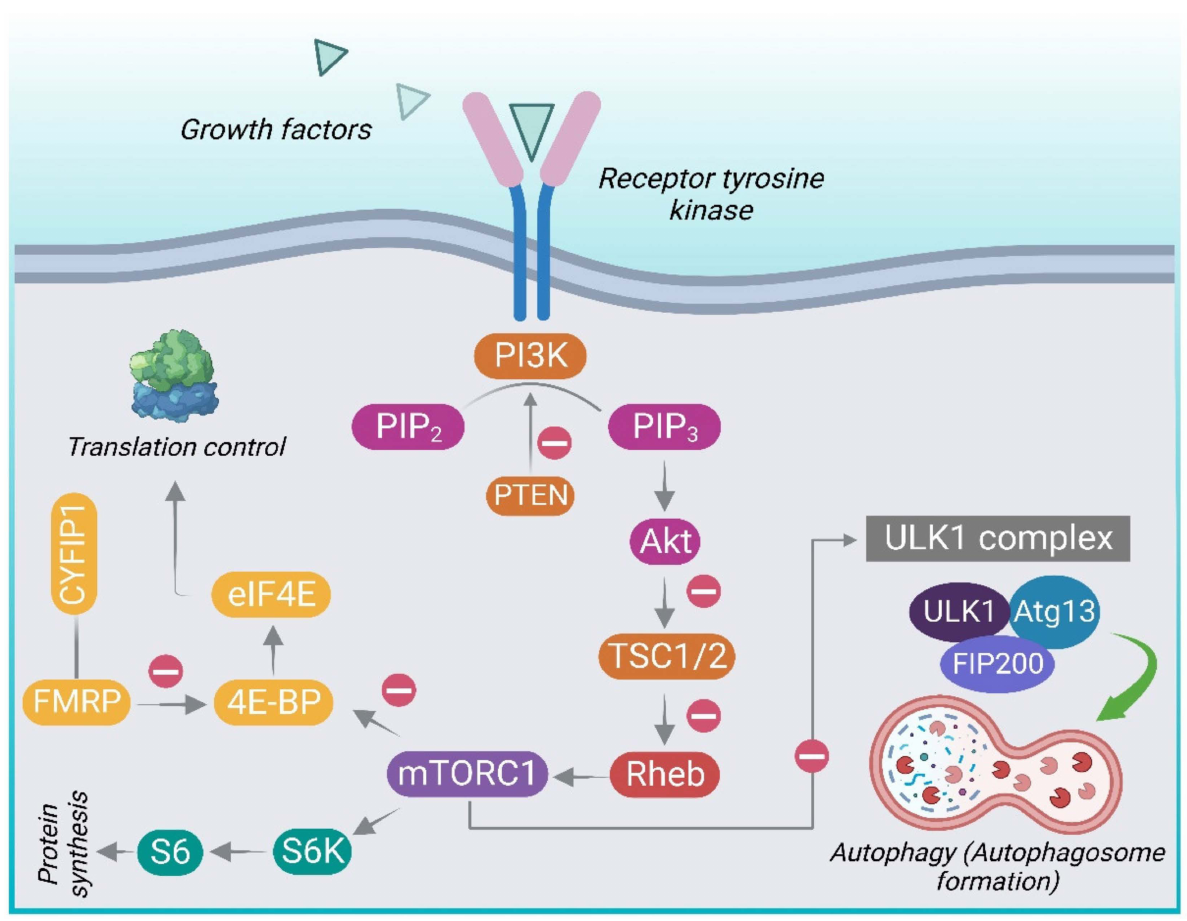
Figure 1. An overview of the PI3K/Akt/mTOR intracellular signaling pathway. Different extracellu- lar stimuli, e.g., growth factors and insulin, mediate their effects by binding to receptors belonging to the receptor tyrosine kinase (RTK) family. This leads to activation of phosphatidylinositol-4,5- bisphosphate 3-kinase (PI3K). PI3K converts phosphatidylinositol (3,4)-bisphosphate (PIP2) into phosphatidylinositol (3,4,5)-trisphosphate (PIP3), which recruits Akt-kinase and stimulates the Akt phosphorylation by PDK1 and mTORC2, on the Thr308 and Ser473 sites, respectively. The activation of the PI3K/Akt pathway through the inhibition of TSC (tuberous sclerosis complex) leads to the activation of mTORC1. Inhibition of the tuberous sclerosis complex (TSC) results in the loss of its abil- ity to convert the Ras homolog enriched in brain active form (RhebGTP) to the inactive GDP-bound form (Rheb-GDP) leading to the subsequent activation of mTORC1. PTEN acts antagonistically to PI3K in conversion of PIP2 to PIP3, functioning as an important negative control. Activation of mTORC1 leads to phosphorylation of p70 ribosomal protein S6 kinase (p70S6K) and 4EBP1 (eu- karyotic initiation factor 4E-binding protein) which, in turn, phosphorylates the ribosomal protein S6 leading to protein translation and synthesis. Active mTORC1 blocks autophagy by inhibitory phosphorylation of the ULK1 complex comprising of autophagy-related proteins (UNC51-like kinase 1 (ULK1), the autophagy-related gene 13 (Atg13), and FAK-family interacting protein of 200 kDa (FIP200). 4E-BP1 prevents translation initiation by sequestering eukaryotic translation initiation factor 4E (eIF4E). mTOR phosphorylates the eukaryotic initiation factor 4E-binding protein 1 (4E-BP1), thereby preventing it from binding to eIF4E, thus liberating eIF4E to enable translation. FMRP (fragile X mental retardation protein) is the protein produced by FMR1gene. FMRP binds to CYFIP1 (cytoplasmic FMRP-interacting protein 1) to form FMRP-CYFIP1 complex that obstructs translation by binding to eIF4E, which is obliterated in fragile X